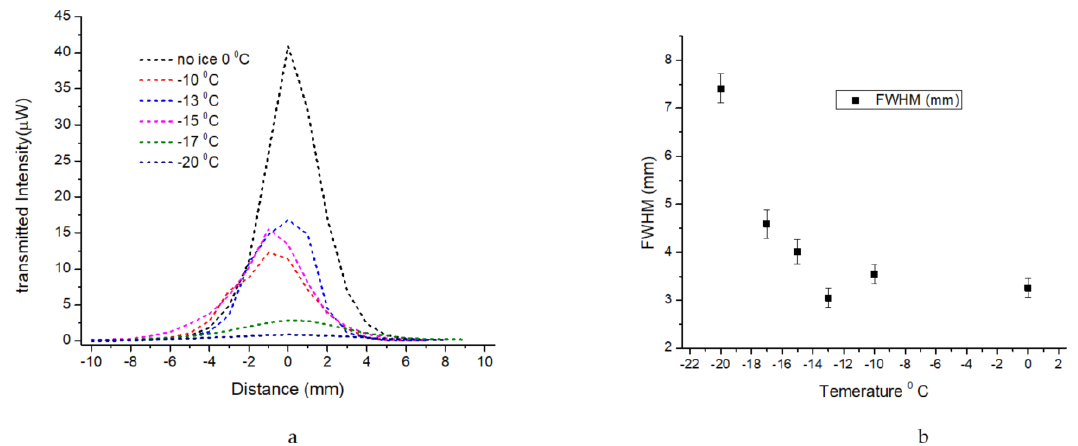
Figure 12. ( a ) Optical diffusion of a laser beam, measured as the transmitted intensity distribution as a function of distance in mm, for ice accreted at different temperatures. ( b ) Optical diffusion measured in mm, manifested as the FWHM of the transmitted intensities through ice accreted at different temperatures.